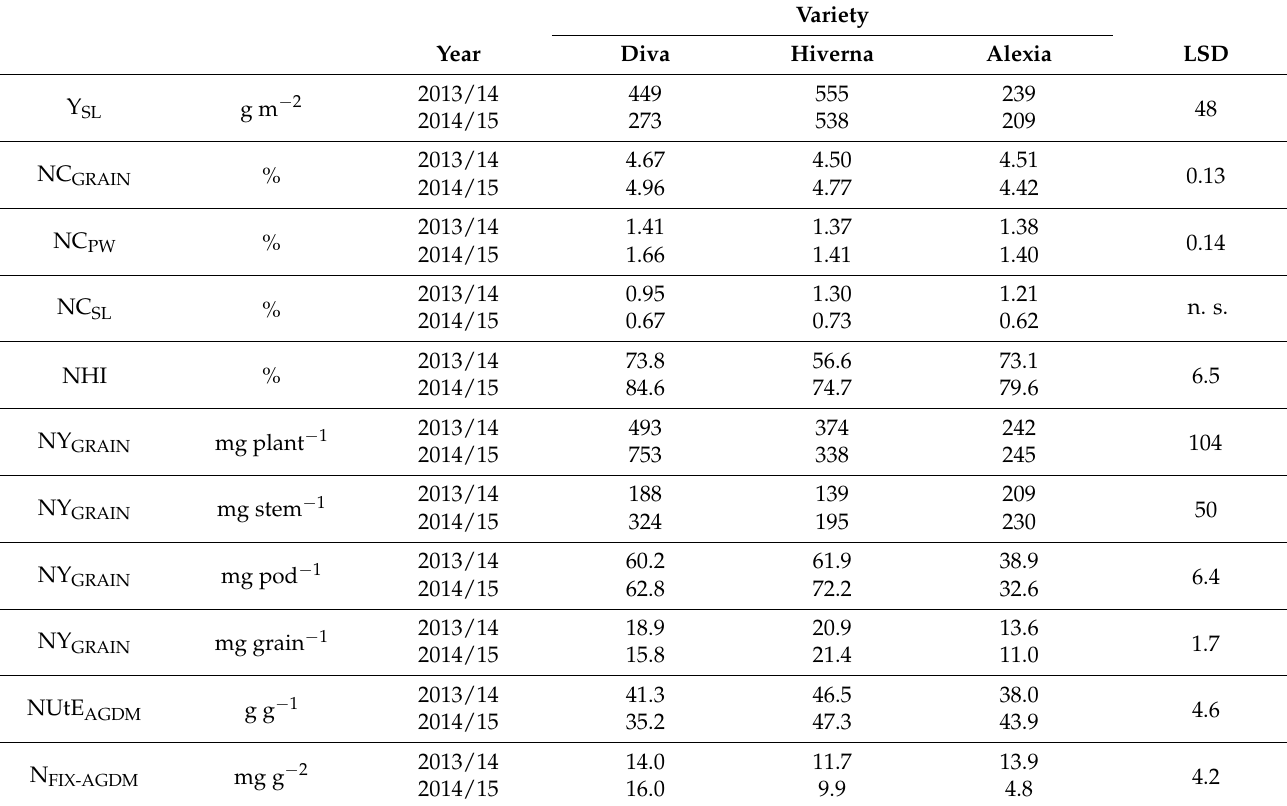
Table 4. Yield and nitrogen parameters of faba bean as affected by variety × year.